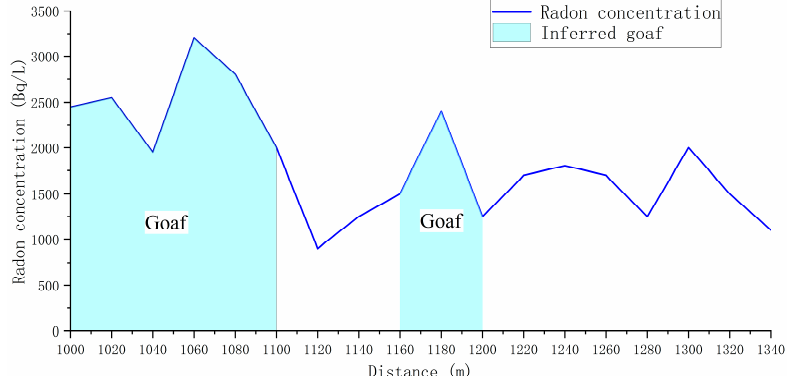
Figure 12. Profile Map of Radon Measurement by Activated Carbon for Survey Line L6.